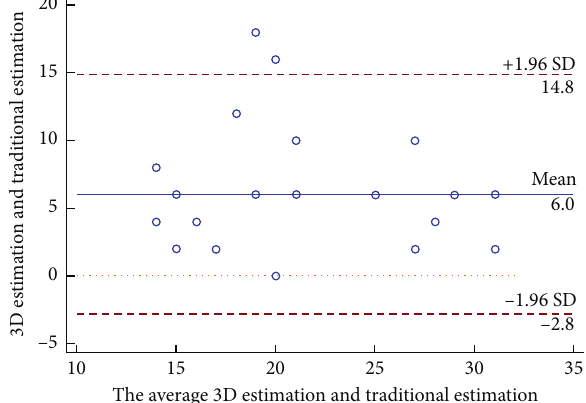
Figure 4: Bland–Altman plot analysis. Bland–Altman plot of empirical estimation versus 3D printed model estimation of occluder